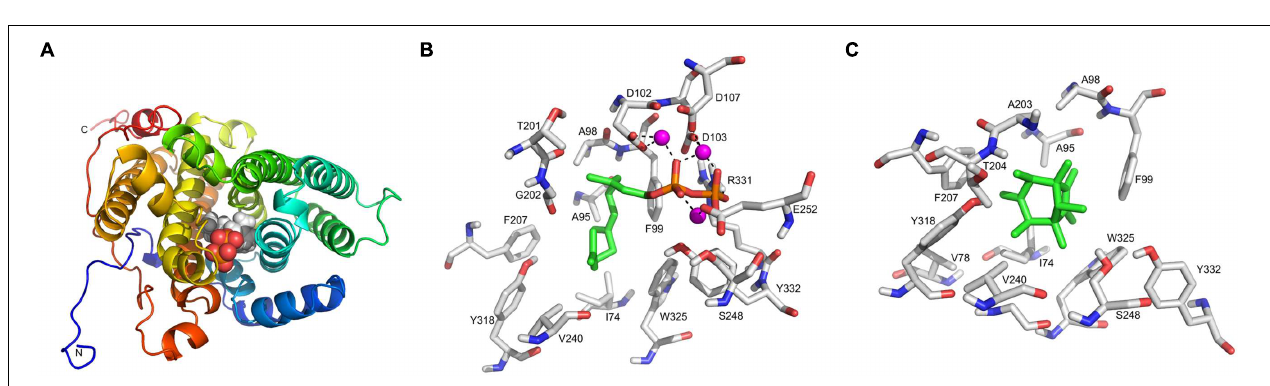
FIGURE 6 | Schematic presentation of conserved motifs in plant and bacterial terpene cyclases. Seven conserved sequence motifs are present in plant terpene synthases. Numbers indicate the amino acids where the motif approximately appears in the protein. Plant terpene synthases are ca. 520 amino acids long. Bacterial terpene synthases are ca. 360 amino acids long and present two conserved motifs and two conserved amino acids. The SOD_c20750 gene, annotated as terpene cyclase of Serratia plymuthica 4Rx13 exhibits the conserved DDXXXDE motif and the conserved R and RY amino acids of bacterial terpene cyclases.